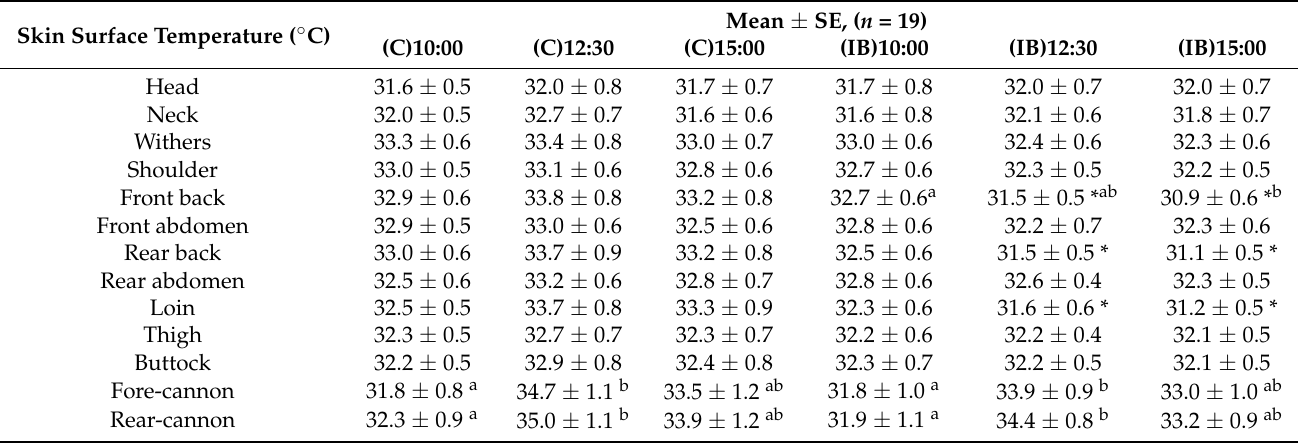
Table 3. Mean ± SE of skin surface temperature.